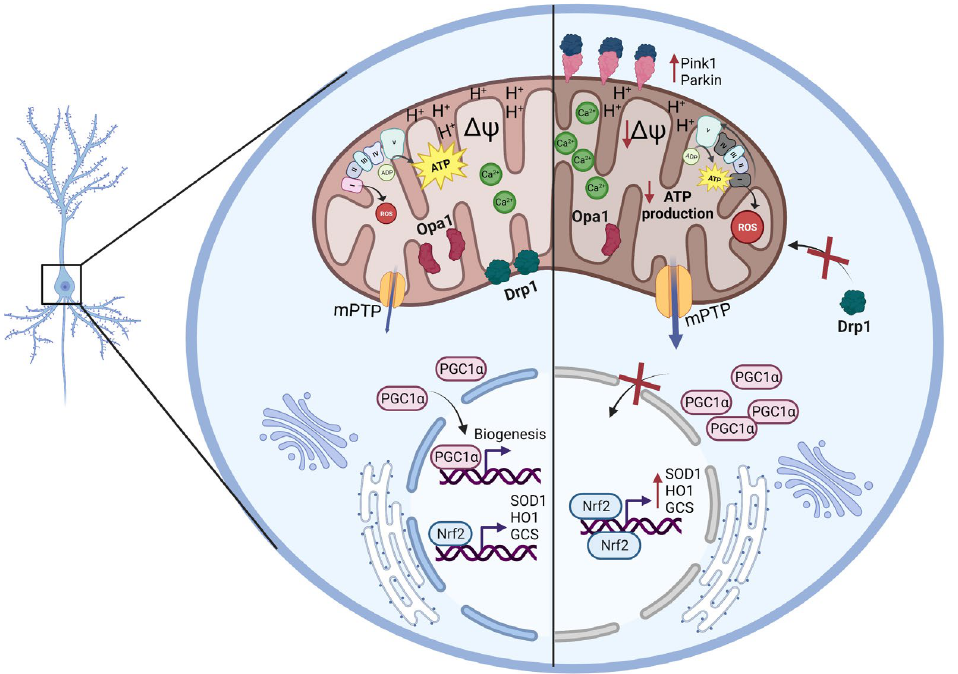
Figure 7. Summary scheme. Representative scheme of our main results. We observed that in the hippocampus of female aged mice, there is a reduction in MMP, along with a reduction in ATP production. We also observed an increase in ROS production, antioxidant enzymes, and in calcium concentration within mitochondria. Moreover, we observed a decrease in dynamic proteins, such as Drp1 and its phosphorylation S616, and Opa1. Finally, we observed a decrease in nuclear levels of PGC1α and an increased recruitment of PINK1 and Parkin to the mitochondria.